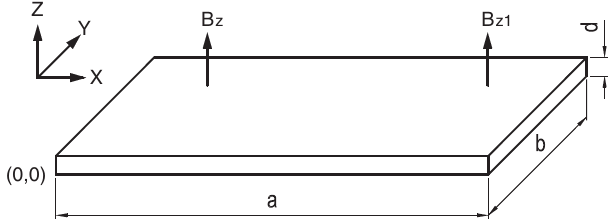
FIG. 1. Coordinate system, plate geometry, and the applied ¼ B is uniform throughout the field. For case I, the field B z z 1 is uniform up to a distance, c ( c < a ) and plate. For case II, B z ¼ f ð x Þ then exponentially decreasing with distance, B z 1